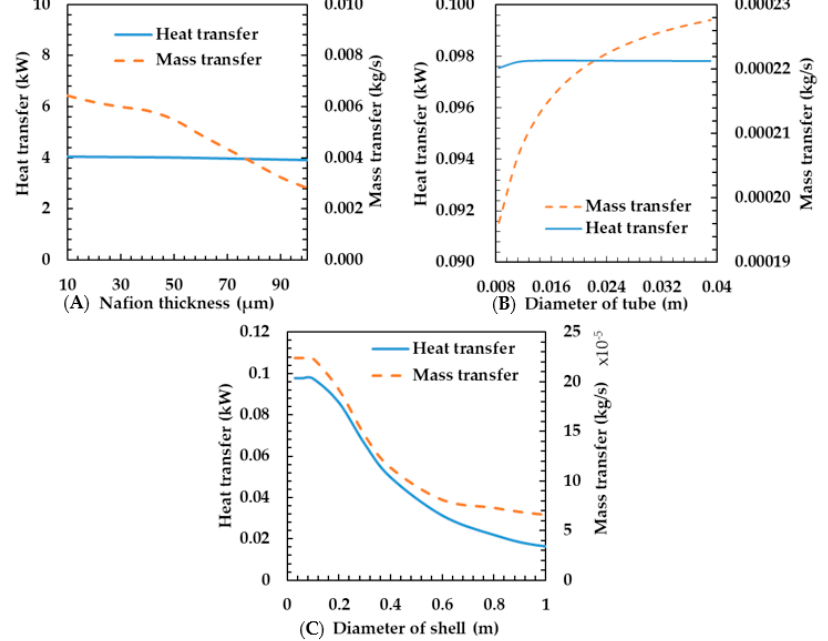
Figure 10. Effects of membrane thickness ( A ), diameter of tube ( B ) and diameter of shell ( C ) on heat and mass transfer rates of the porous metal foam humidifier. and mass transfer rates of the porous metal foam